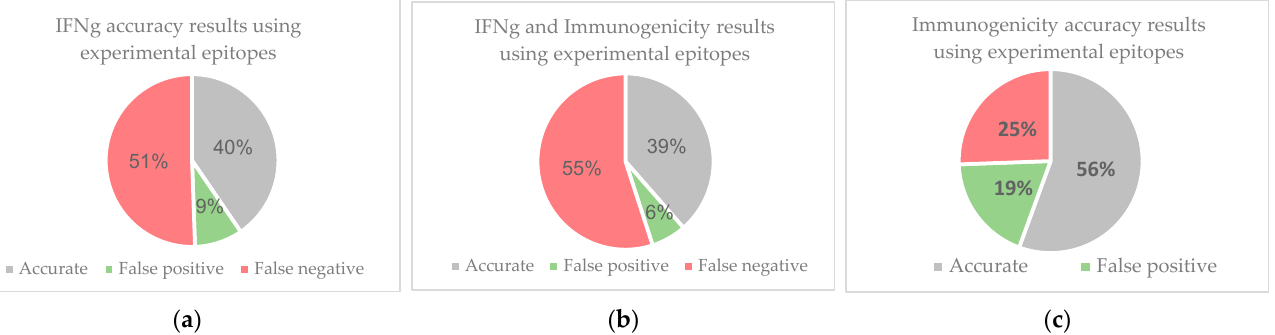
Figure 7. IFNepitope, Immunogenicity, and combined accuracy using experimental immunogenicity cancer epitopes with positive IFN γ release. Experimental data were collected from